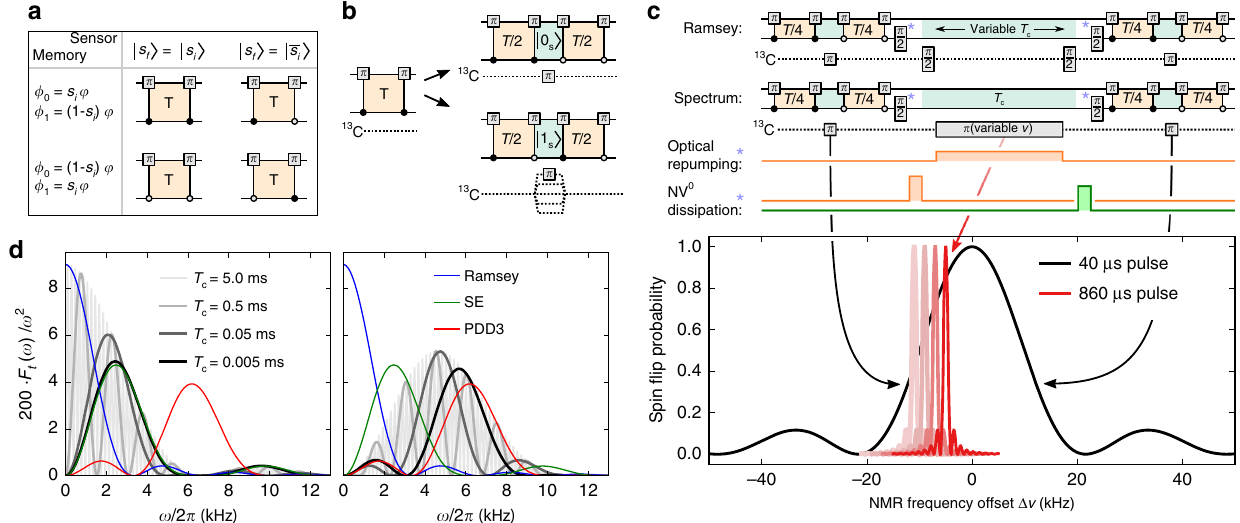
Fig. 5 Design of sensing sequences. a Four sensing steps with DqMA used to create different sensing tasks. Every sensing step starts with the sensor spin prepared in an eigenstate and the memory spin in a superposition state. These sensing steps have two tasks: accumulate a phase on one of the components of the memory spin (i.e., ϕ 0 or ϕ 1 ), and either fl ip or keep the sensor-spin state (i.e., s f Ramsey-type sensing step into an echo-type sequence comprising two sensing steps and an intermediate fl ip of target spins to facilitate assignment. Flips can be selective, by turning on the hyper fi ne gradient during the pulse (lower part). c Sensing sequences used in Figs. 2 – 4. Optional elements are marked with a blue star. The optional π /2 pulses on the memory spin convert quantum into classical storage and vice versa. The optional laser pulse sequences realize different decoupling methods. The outer short π pulses on the 13 C spins fi lter the accumulated signal in a broad spectral range of NMR frequencies, whereas the central, longer-lasting π pulse provides high-frequency resolution. The lower part illustration the spectral fi lters for 13 C target spins from the above sequence. The overall signal results from target spins that are fl ipped by all three pulses. d Noise fi lter functions of the used detection sequences acting on sensor and memory, in comparison to commonly known detection schemes acting only on the sensor (spin echo (SE), periodic dynamical decoupling (PDD)). On the left, the sensing steps as shown in ( a ) are used for encoding and decoding, whereas the right graph incorporates the echo-type sequence, shown in ( b